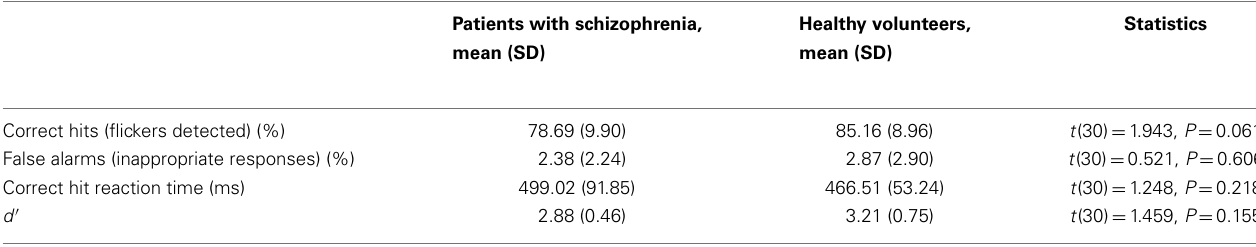
Table 2 | Behavioral data from the visual change task.